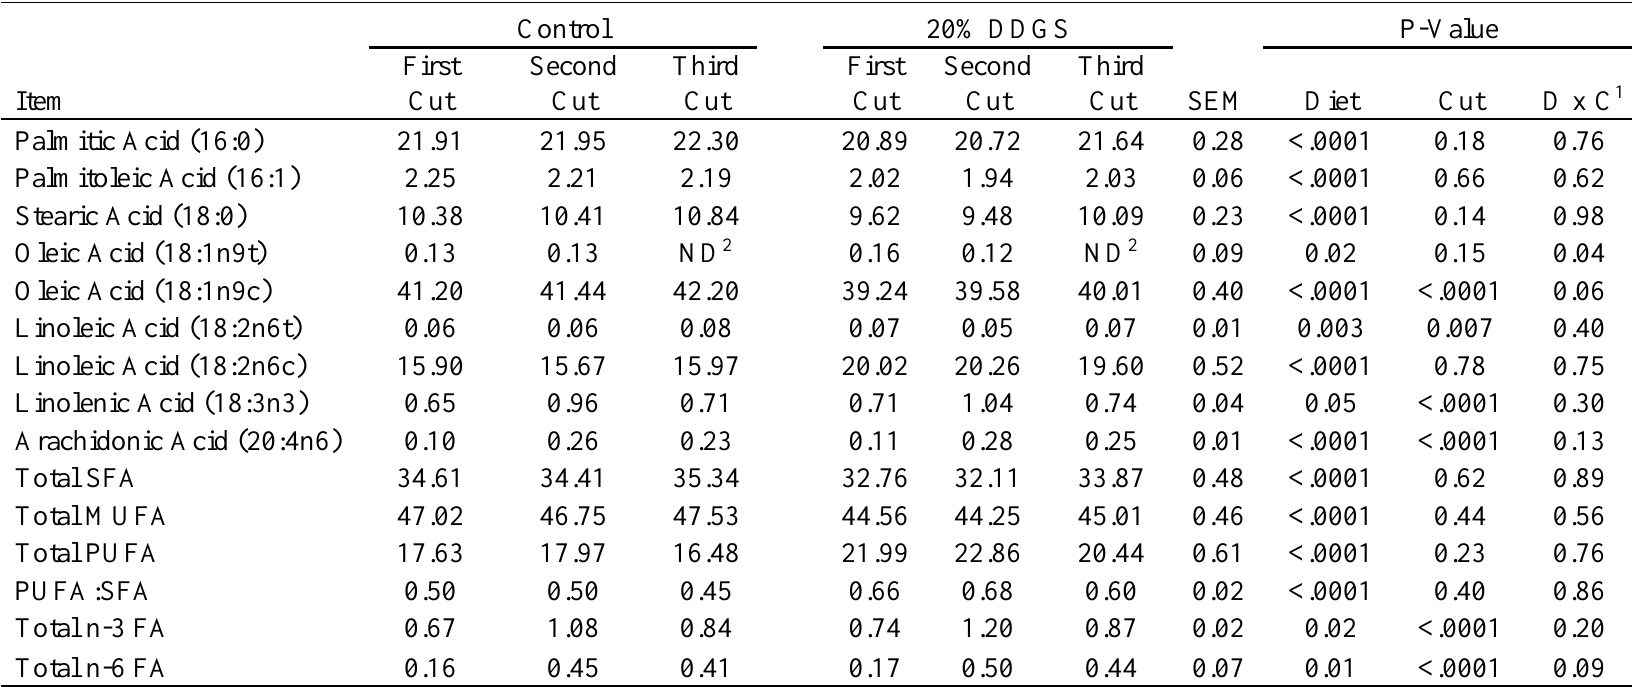
Table 5. Interactive effects of 20% DDGS in the diet and marketing time on fatty acid (FA) composition of jowl fat Control 20% DDGS